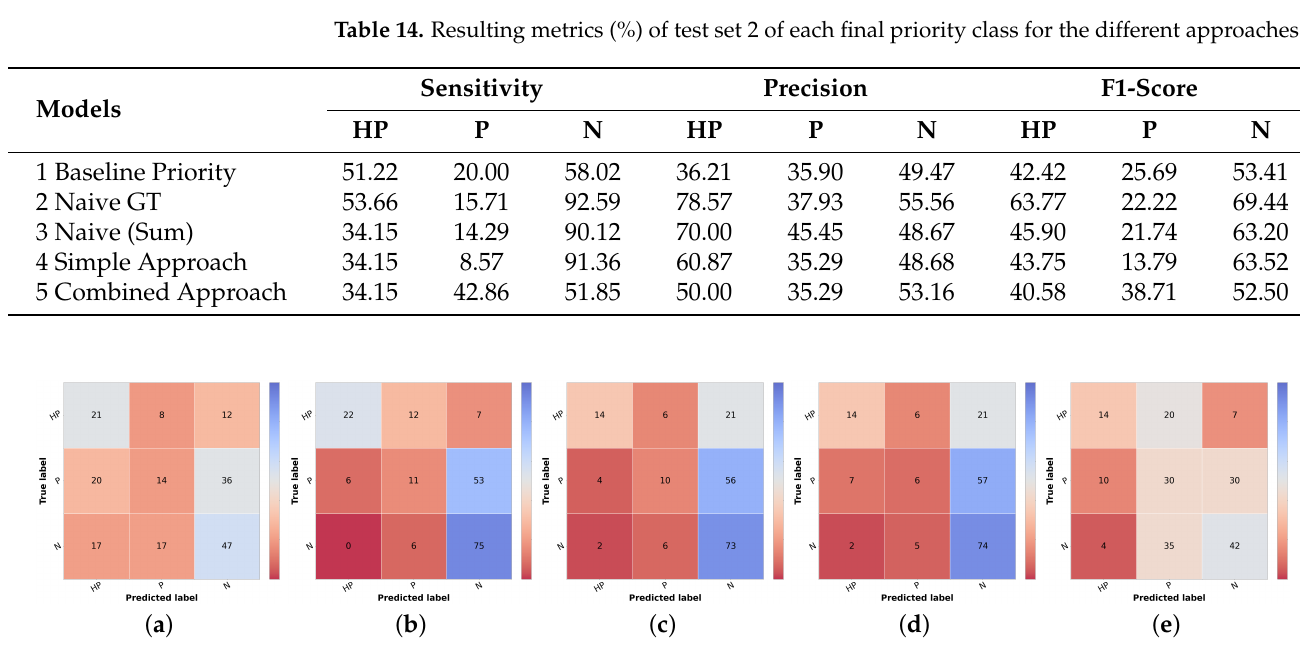
Figure 7. Confusion matrices of test set 2 for the different risk prioritization approaches